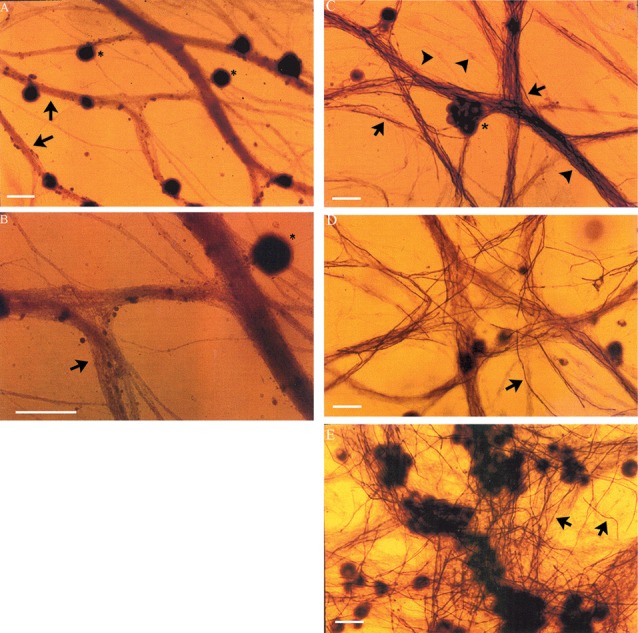
Neurites extended from DRG sensory neurons in vitro become myelinated in co-cultures with chronically denervated SCs. Myelination of the axons is not evident in the absence of SCs but it proceeds normally in SC-DRG sensory neuronal co-cultures, even after chronic SC denervation. (A,B) DRG neurons (*) maintained in culture for 24 days without SCs, were not myelinated as indicated by the arrows and seen by absence of Sudan Black staining in the unmyelinated axon bundles. Magnification was 20× (A) and 40× (B). (C–E) DRG axons were myelinated when DRG neurons were co-cultured with SCs whether or not the SCs were acutely denervated (C: 7 days) or chronically for 7 weeks (D,E) or 17 months by transecting and ligating the sciatic nerve in vivo in the right and left hindlimbs, respectively, prior to co-culture. Scale bar = 30 μm.